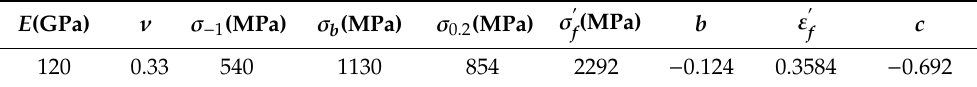
Table 2. Material parameters of TC11 at room temperature